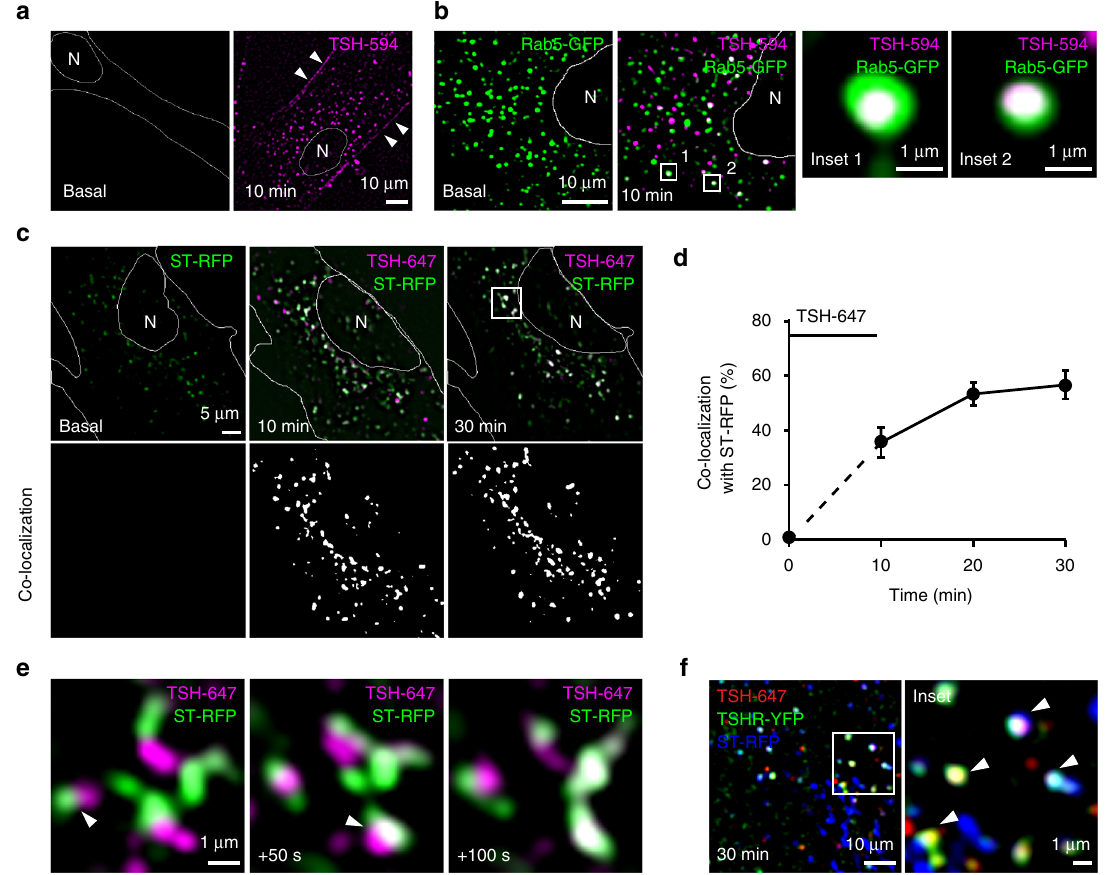
Fig. 1 TSH/TSHR complexes traf fi c retrogradely to the TGN. Primary mouse thyroid cells were stimulated with fl uorescent TSH (TSH-594 or TSH-647) for 10 min to visualize internalized TSH/TSHR complexes. When indicated, the cells were previously transfected with different combinations of subcellular markers. Shown are images at the indicated time points from beginning of stimulation. a Representative images of non-transfected cells obtained before stimulation and at 10 min, showing TSH bound to the plasma membrane and inside intracellular vesicles. The focus in the images shown in a was speci fi cally set to also visualize TSH at the plasma membrane (arrowheads). b Simultaneous visualization of the early endosome marker Rab5-GFP and TSH-594. Representative images of the same cell obtained before and 10 min after stimulation are shown. Insets correspond to the regions marked with white boxes. c Time series showing accumulation of TSH-647 with the TGN-marker ST-RFP. White pixels in co-localization images indicate regions where TSH-647 and ST-RFP were simultaneously present. d Quanti fi cation showing the percentage (mean ± s.e.m.; n = 14 cells) of TSH-containing structures co- localizing with ST-RFP over time, calculated from images like those in c . e Enlarged view of the region delimited by the white box in c , showing individual fusion events ( arrowheads ). Time is given relative to the fi rst image. f Simultaneous visualization of transfected TSHR-YFP, ST-RFP ( blue ) and TSH-647. Shown is a representative image acquired 30 min after stimulation. Inset corresponds to the region marked with the white box. White indicates triple co- localization. Arrowheads point to TSH/TSHR complexes in vesicles and tubules of the TGN. Where appropriate, cell edges and nucleus (N) are marked in white. Data in a – c and f are representative of 3, 3, 4 and 3 independent experiments,